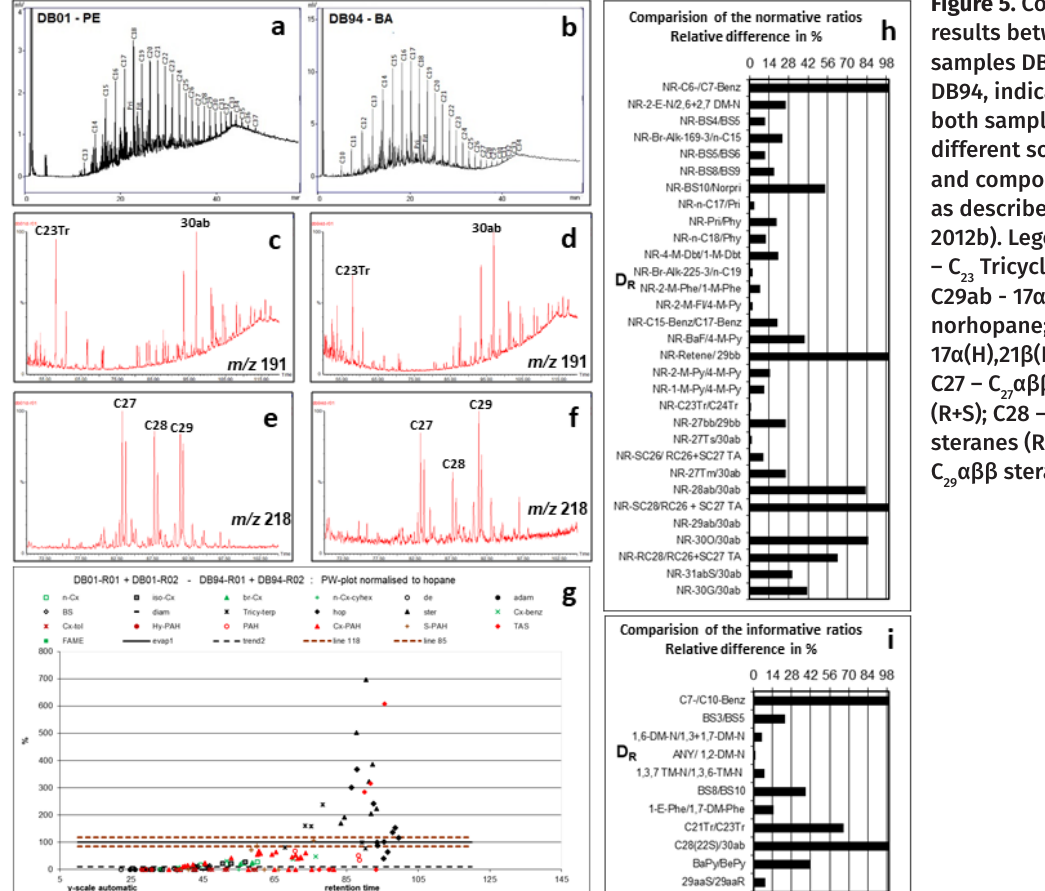
Figure 5. Combined results between samples DB01